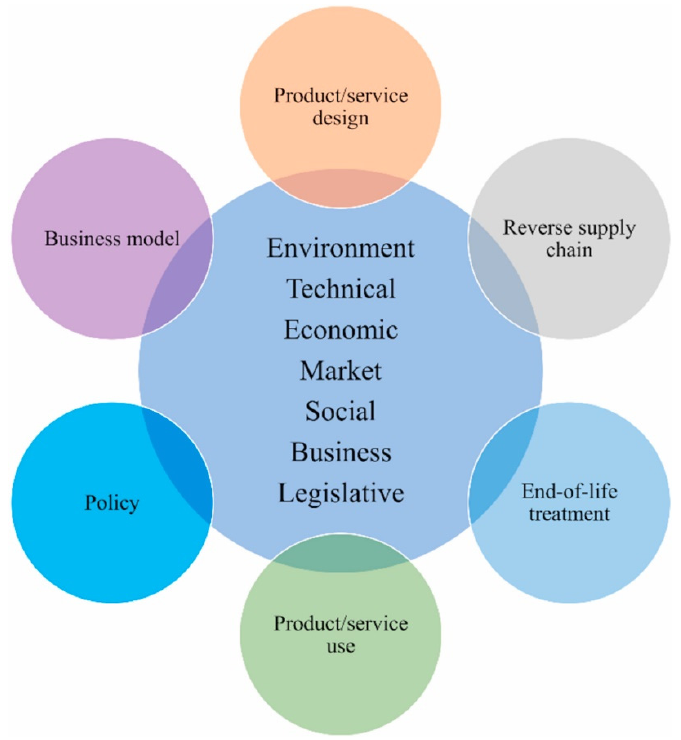
Figure 2. Building blocks of circular economy. Adapted with permission from Ref. [22]. © 2021 Elsevier Ltd.